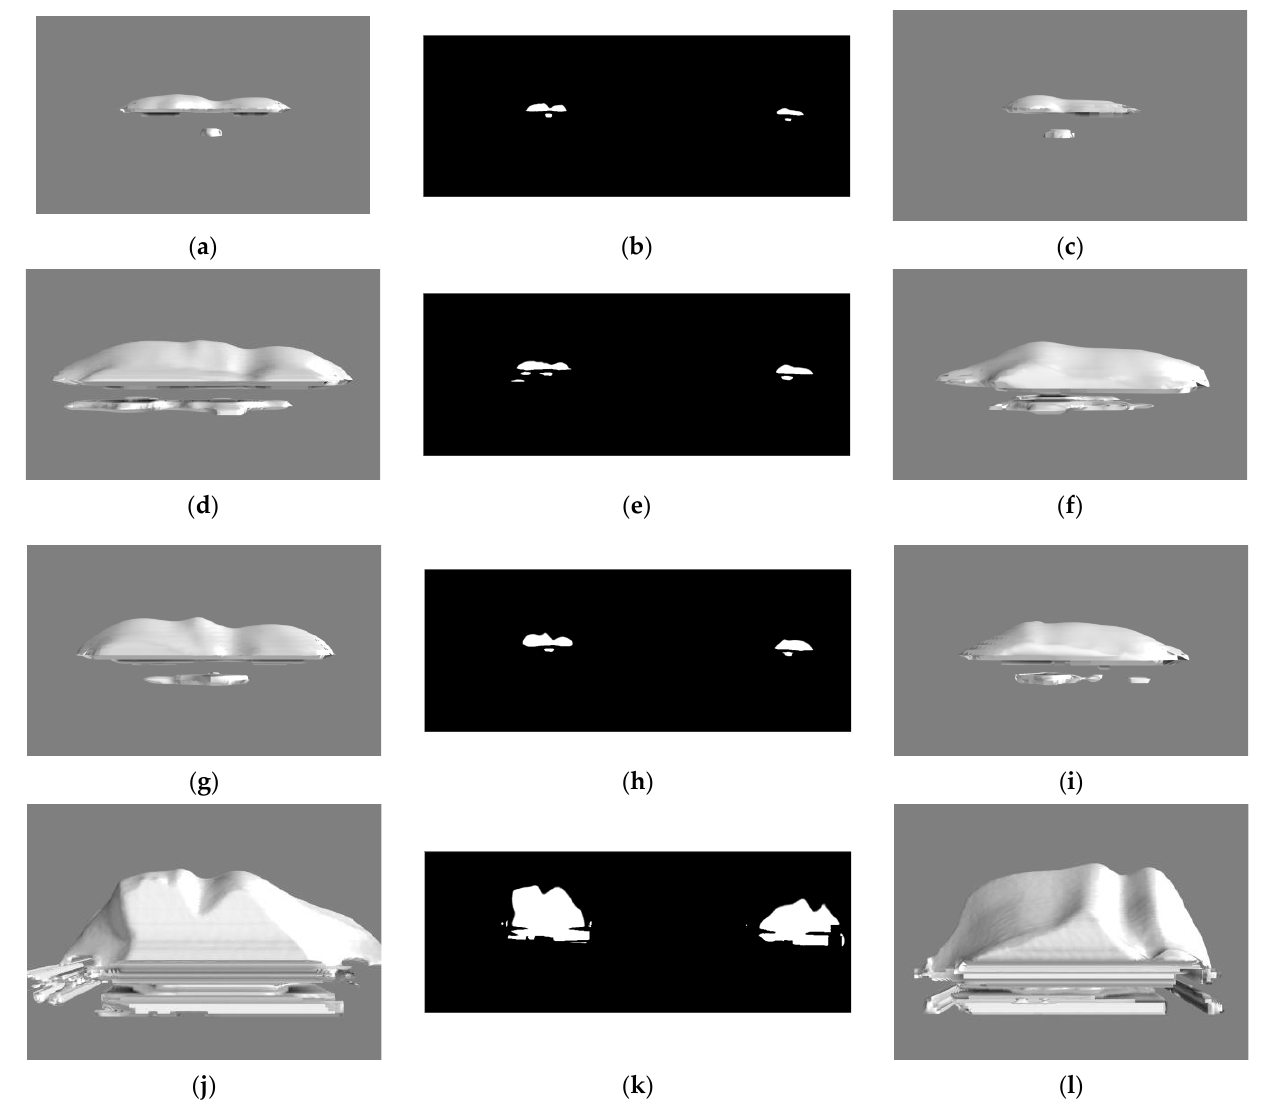
Figure 14. Results for all measurements without magnetic nozzle: ( a ) left direction of observation 10 ns; ( b ) recording 10 ns; ( c ) right direction of observation 10 ns; ( d ) left direction of observation 500 ns; ( e ) recording 500 ns; ( f ) right direction of observation 500 ns; ( g ) left direction of observation 750 ns; ( h ) recording 750 ns; ( i ) right direction of observation 750 ns; ( j ) left direction of observation 10 µs; ( k ) recording 10 µs; ( l ) right direction of observation 10 µs.